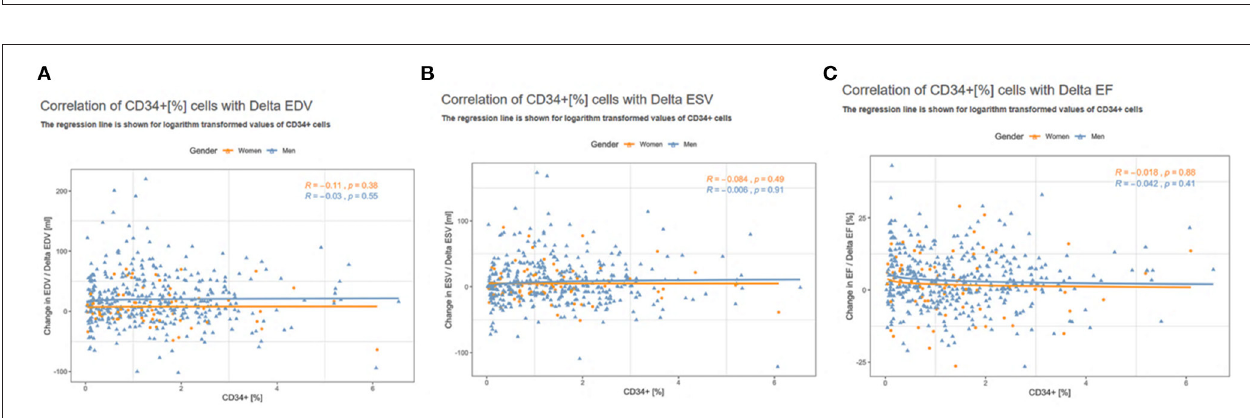
FIGURE 4 | Kaplan-Meier curves for CD34 + cells stratified by quartiles and clinical outcomes. (A) Major adverse cardiac and cerebrovascular event(s) (MACCE). (B) Death. (C) Composite endpoint (mortality, stroke, acute myocardial infarction). (D) Target-vessel revascularization.